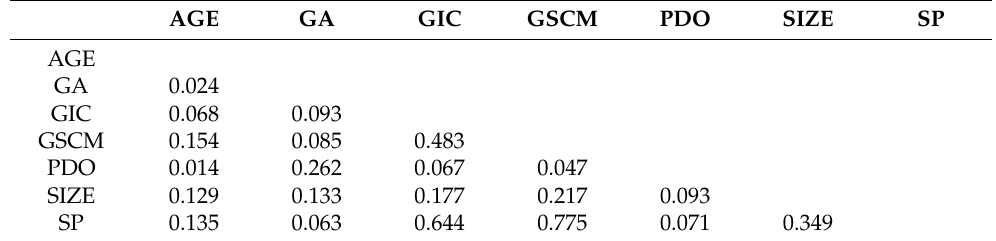
Table 4. Discriminant validity analysis based on the Heterotrait–Monotrait criterion. AGE